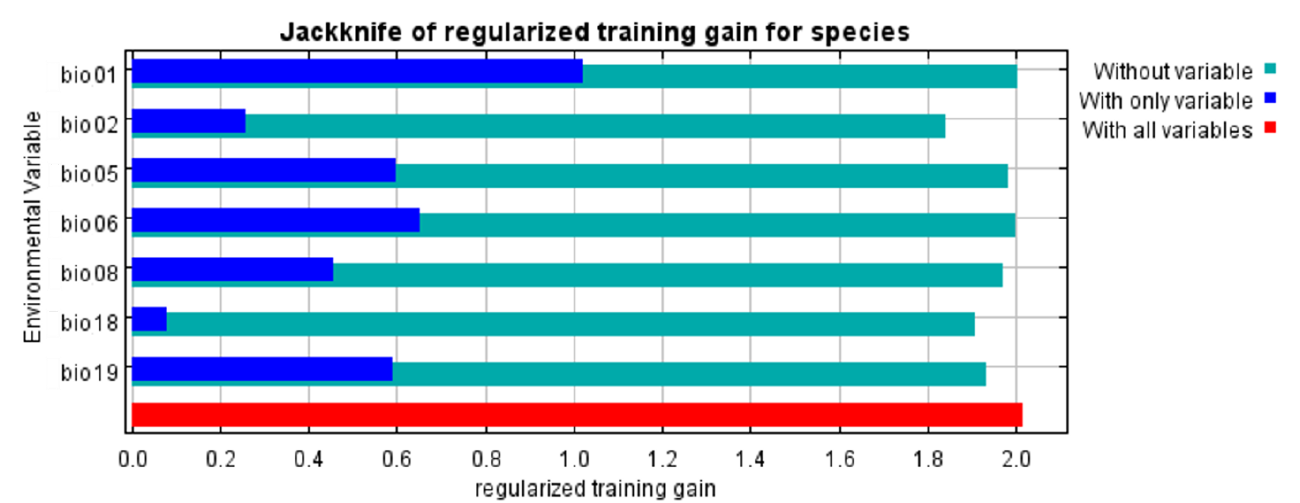
Figure 4. Relative importance of seven selected environmental variables of Phytoseiulus persimilis based on the jackknife test.